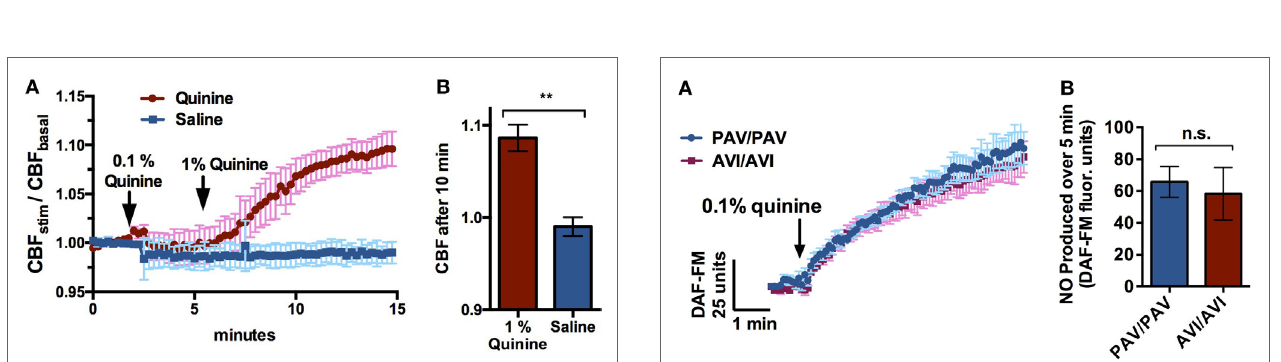
FigUre 2 | Quinine-induced nitric oxide (NO) release [as assessed by 4-amino-5-methylamino-2 ′ ,7 ′ -difluorescein (DAF-FM)] is significantly attenuated by U73122, a phospholipase C β 2 blocker, which is necessary for T2R-mediated signaling. This attenuation is not observed with incubation with U73343, an inactive analog of U73122 ( n = 6–9 cultures). (a) NO release over a period of 5 min, and (B) maximal NO release during that same period. * p < 0.05, ** p < 0.01.